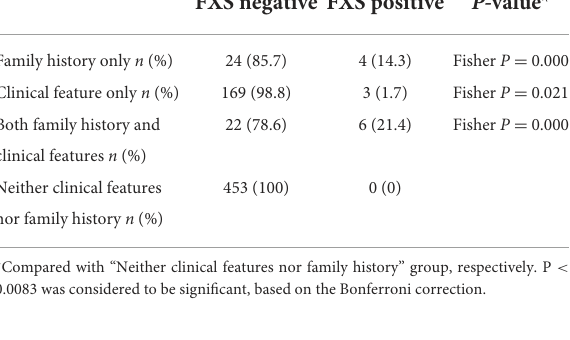
TABLE 3 Comparison of the yield of fragile X testing in unexplained ID/GDD individuals with or without clinical features and family history